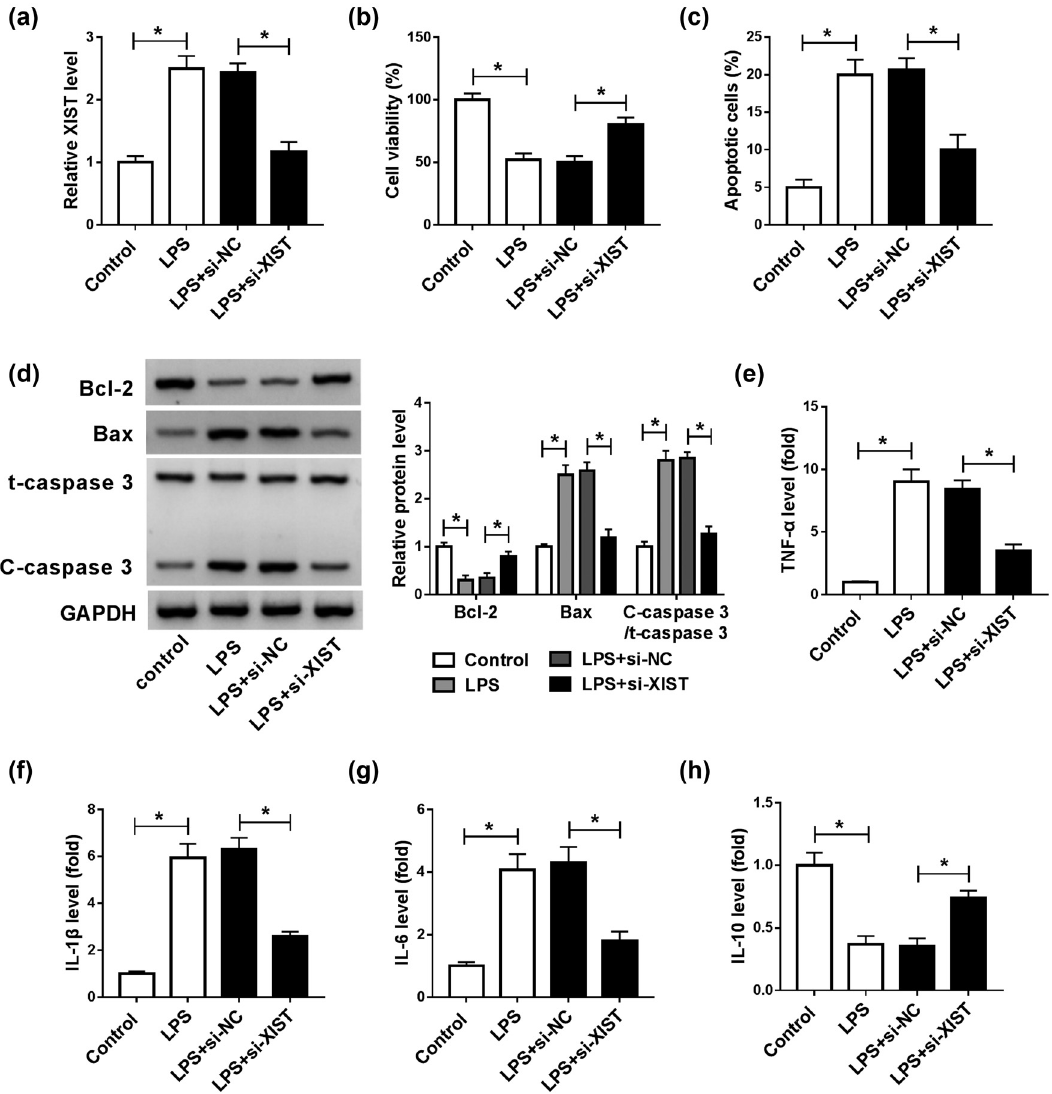
Figure 3: XISTsilencingrestoredtheimpactsofLPSoncellviability,apoptosis,andin fl ammationinBV2cells.BV2cellsweretransfectedwithsi - XISTor si - NCandthentreatedwith100ng/mLLPS. ( a ) TheexpressionlevelofXISTinBV2cellswasdeterminedbytheRT - qPCRassay. ( bandc ) Theviabilityand apoptosisofBV2cellswereevaluatedthroughCCK - 8assayand fl owcytometryanalysis. ( d ) TheproteinlevelsofBcl - 2,Bax,t - caspase3,andC - caspase 3 in BV2 cells were examined by western blot assay. ( e – h ) The secretion of TNF - α , IL - 1 β , IL - 6, and IL - 10 in BV2 cells was detected by ELISA. * P <